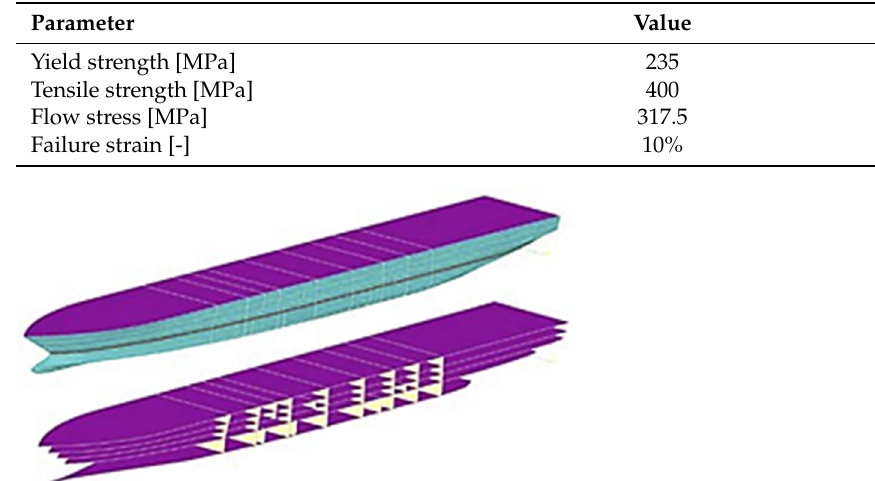
Table 7. Material parameters considered.